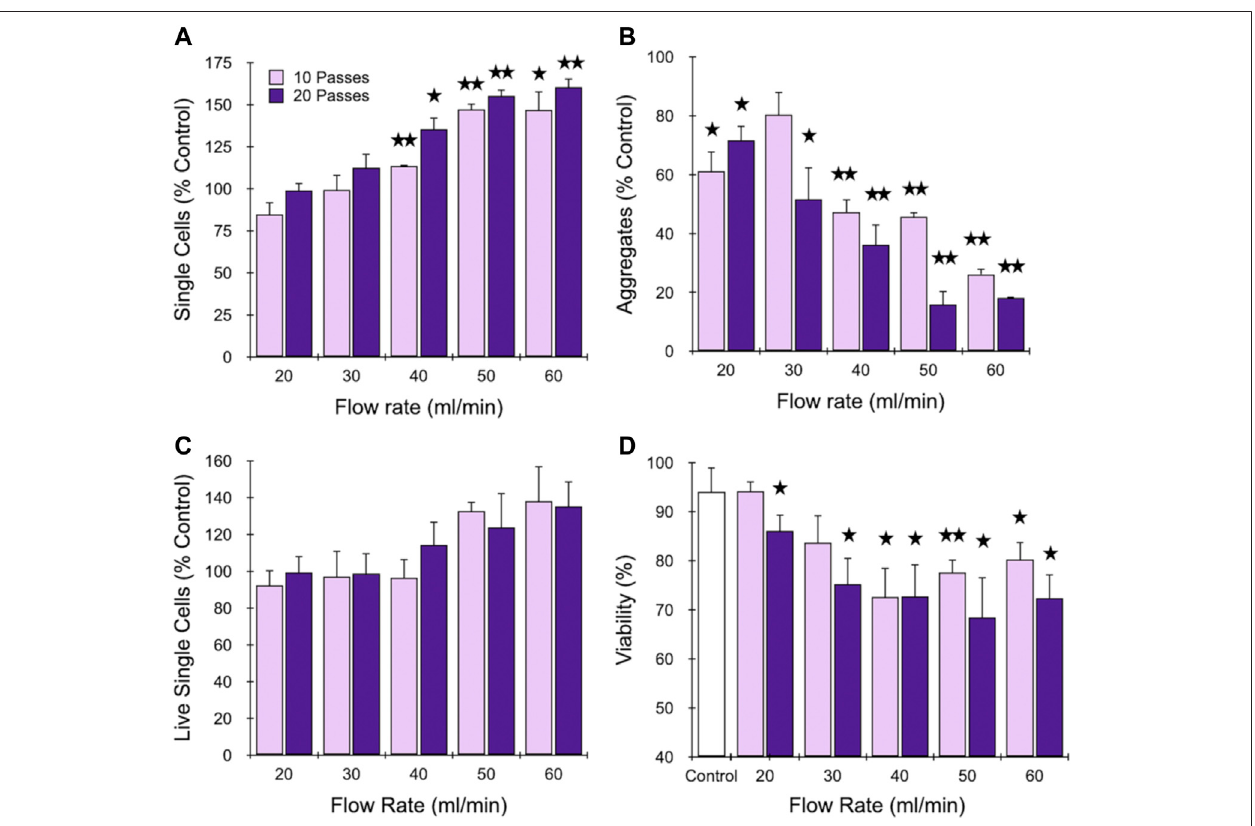
FIGURE2| Optimizationofthebranchingchannelarrayusingcellaggregates.MCF-7cellswerepassedthroughthechannelsatdifferent fl owratesforeither10or 20 passes. Results are shown for (A) total single cell, (B) aggregate, and (C) live single cell yields, which are all normalized to the control that did not pass through the device. Also presented is (D) single cell viability. Strong effects were observed for each metric above 40 ml/min, but higher pass number did not substantially in fl uence results. Dataarepresentedasmeanvalues±SEMfrom atleast threeindependentexperiments. Two-sided t test wasused forstatisticaltesting. Starsindicate p < .05 and double stars indicate p < .01 relative to the unprocessed